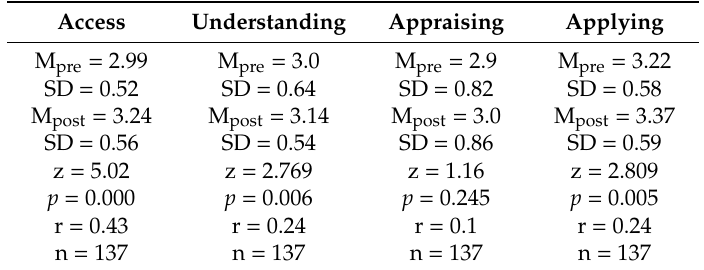
Table 3. Results of the health dimensions of accessing, understanding, appraising and applying health